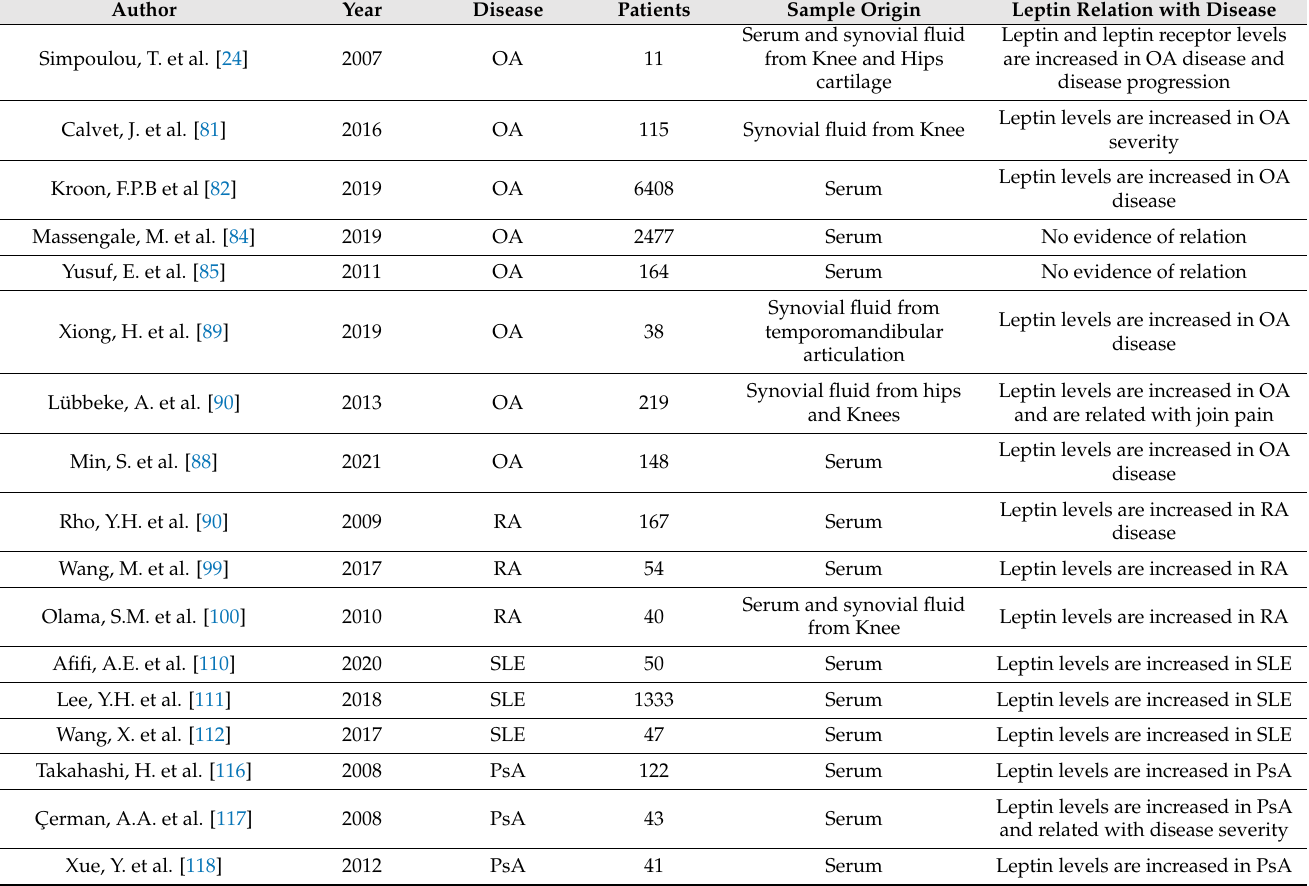
Table 1. Summary of all cited studies about the role of leptin in human cartilage